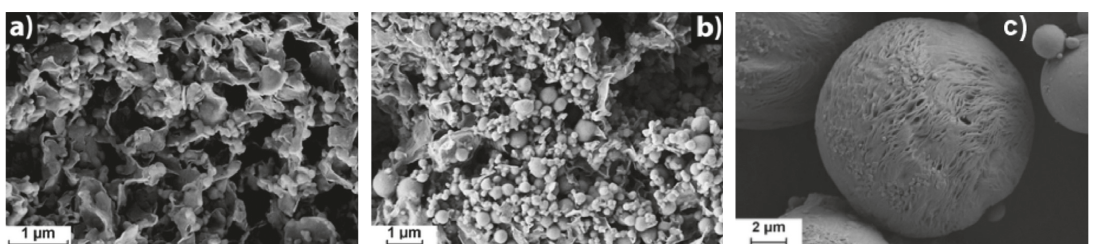
Figure 8: Micrographs of micro- and nanoparticles of PHBV prepared by nanoprecipitation method using 0.5% PHBV in dime- thylformamide (DMF) as solvent and water as antisolvent (a) and 0.1% PHBV in DMF as solvent and 10% NaCl solution in water as antisolvent (b); microparticles of PHBV prepared by emulsification/solvent evaporation method using 1% PHBV in dichloromethane (DCM) and sodium dodecyl sulphate (SDS) as surfactant in a concentration of 1% (c) (adapted with permission from ref.